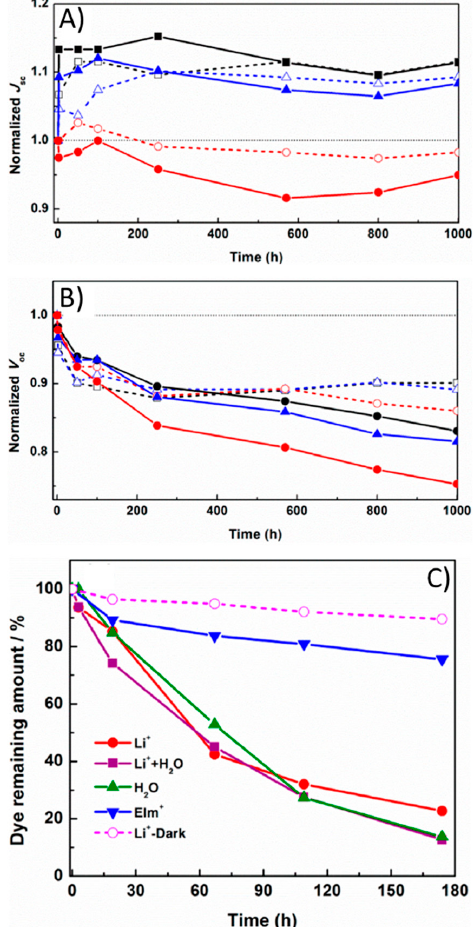
Figure 4. ( A,B ) Evolution of photovoltaic parameters with aging time for DSCs having different cation compositions: cation ‐ free ( ■ ), Li + ( ● ) and EIm + ( ▲ ) under full sun illumination (390 ‐ nm cut ‐ off filter, solid lines) and in dark conditions (dashed lines) at a temperature of 60 °C. All data are normalized with respect to the initial value. All of the electrolytes were prepared in air according to the same recipe: Co(bpy) 3 [B(CN) 4 ] 2+/3+ 0.30 M/0.15 M, TBP 0.20 M and 0.10 M of cation co ‐ additives. ( C ) Degradation rates of the 20 μ M D35/acetonitrile solution containing different additives: anhydrous Li + 5 mM, anhydrous Li + 5 mM + H 2 O 50 mM, H 2 O 50 mM, EIm + 5 mM, recorded with aging time on exposure to light at 60 °C; a cell laden with anhydrous Li + 5 mM on exposure at 60 °C is also shown. Adapted and reprinted from [52].